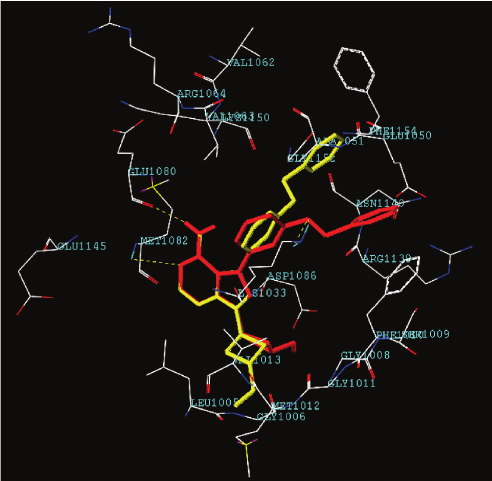
Figure 3: CoMFA steric maps with the most (red) and least (or- ange) active compound within the active site.